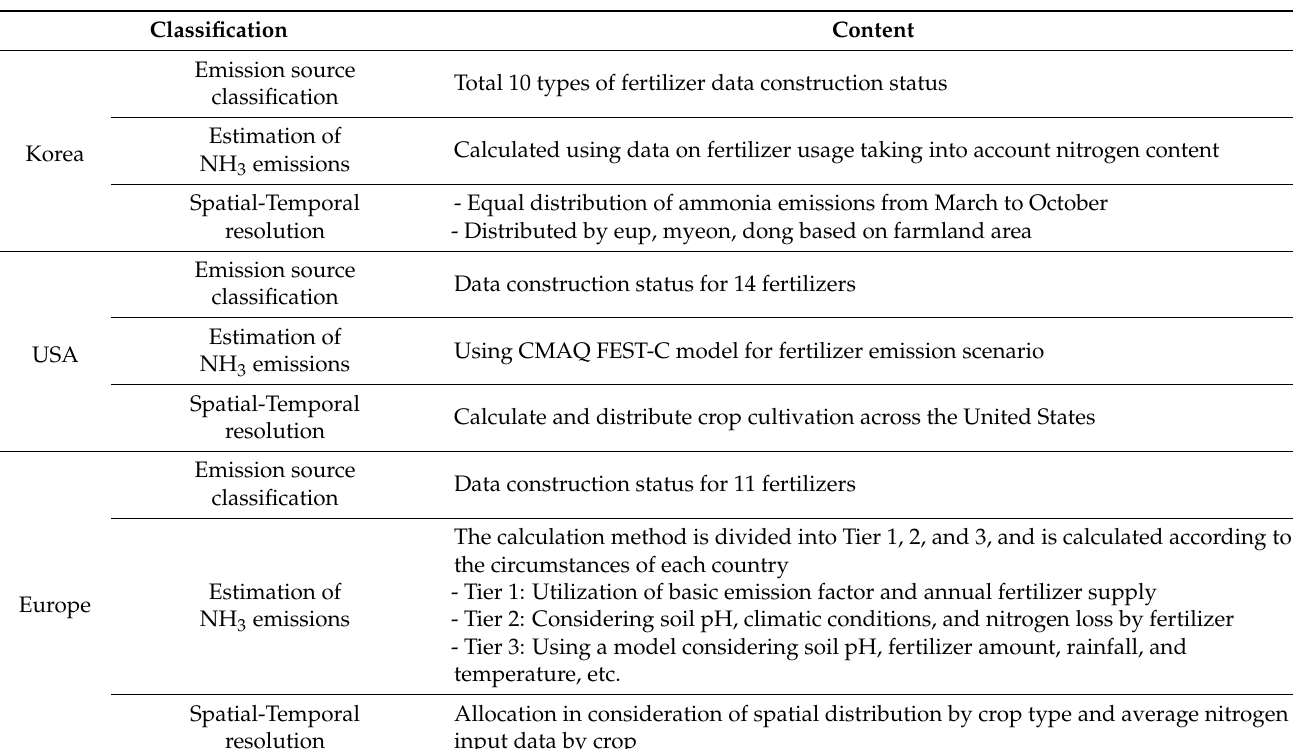
Table 1. Comparison and Implications of Ammonia Inventory in the World Agricultural